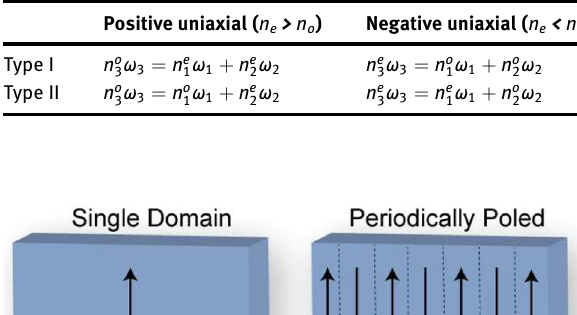
Table  : Strategies to achieve phase matching in uniaxial crystals.